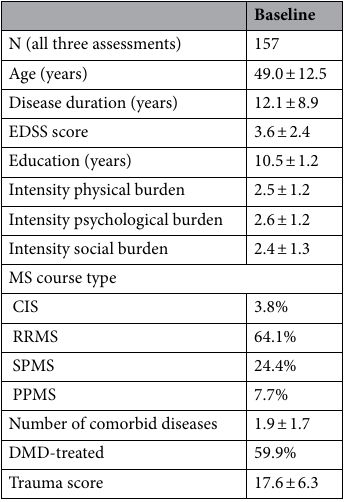
Table 1. Patient characteristics at baseline. CIS clinically isolated syndrome, DMD disease modifying drug, EDSS expanded disability status scale, MS multiple sclerosis, N number of patients PPMS primary progressive MS, RRMS relapsing–remitting MS, SPMS secondary progressive MS.